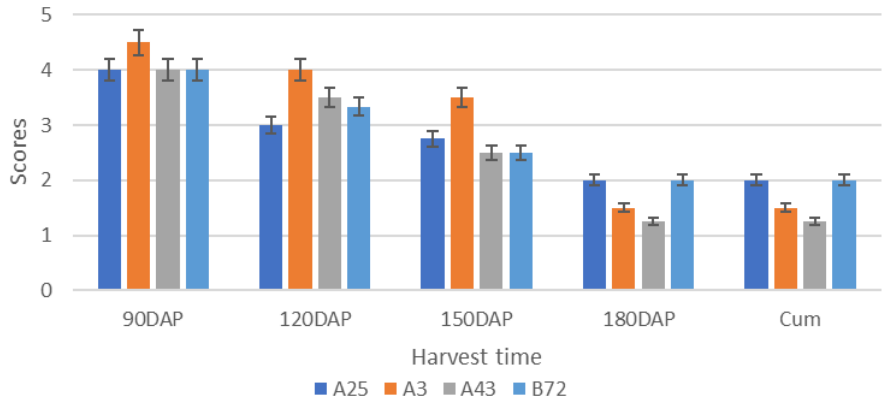
Figure 3. Growth trend of scores over four harvest times for discontinuous storage root formation and bulking genotypes A3, A25, A43 and B72 decreases due to progressive reduction of newly formed storage roots and similar bulking across all storage roots of the same genotype. Note: DAP = days after planting; CSRFAB = Continuous storage root formation and bulking; Cum. = Cumulative scores. DCSRFAB = discontinuous storage root formation and harvesting. Trend of scores over four harvest times for DCSRFAB genotypes A3, A25, A43 and B72 decreases due to progressive reduction of newly formed storage roots and similar bulking across all storage roots of the same genotype. The cumulative scores are generally lower than the respective maximum scores due to to the rate of CSRFAB decreasing in late stages.